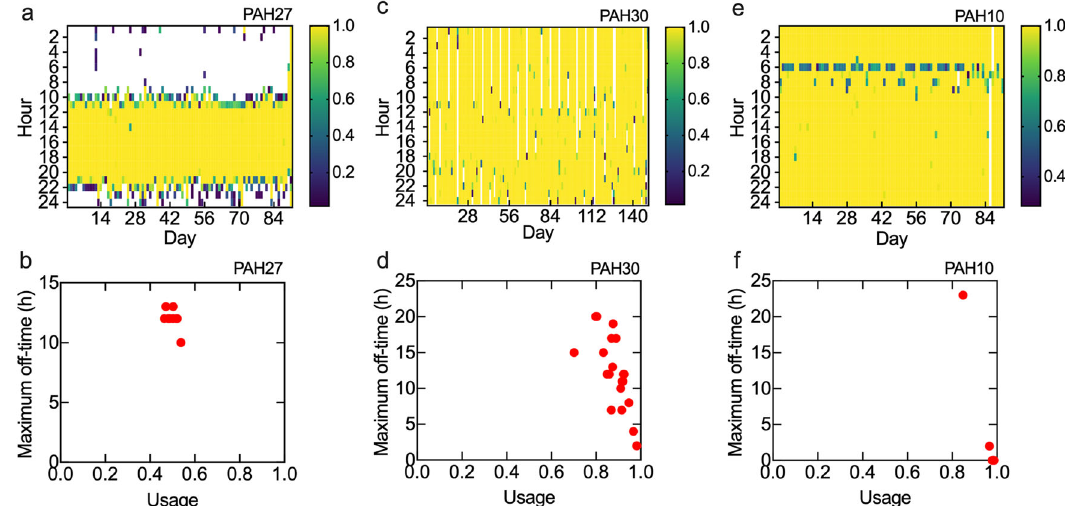
Fig. 5 Examples of heat maps of device usage and maximum off time. Heat maps show usage for each hour of each day during the trial. The legend indicates the fraction of an hour that the device was worn with HR > 0. Yellow cells indicate that the device was worn continuously for the full hour. White cells indicate that the device was not worn (no HR recorded) for the full hour. a Heat map for PAH27 (13 weeks of data), showing low usage (average = 0.49) with the device not worn overnight. b The maximum off time for each week for PAH27 is consistently around 12 h overnight. Each point represents the maximum off-time for each week in the trial. c Heat map for PAH30 (22 weeks of data), showing relatively high usage (0.90), with the device removed for several hours every few days. d The maximum off time for PAH30 is typically 8 – 20 h and includes overnight hours. e Heat map for PAH10 (13 weeks of data), showing high usage (0.97). For the fi rst 10 weeks the maximum off-time is less than 1 h. f The maximum off time for PAH10 is usually less than 1